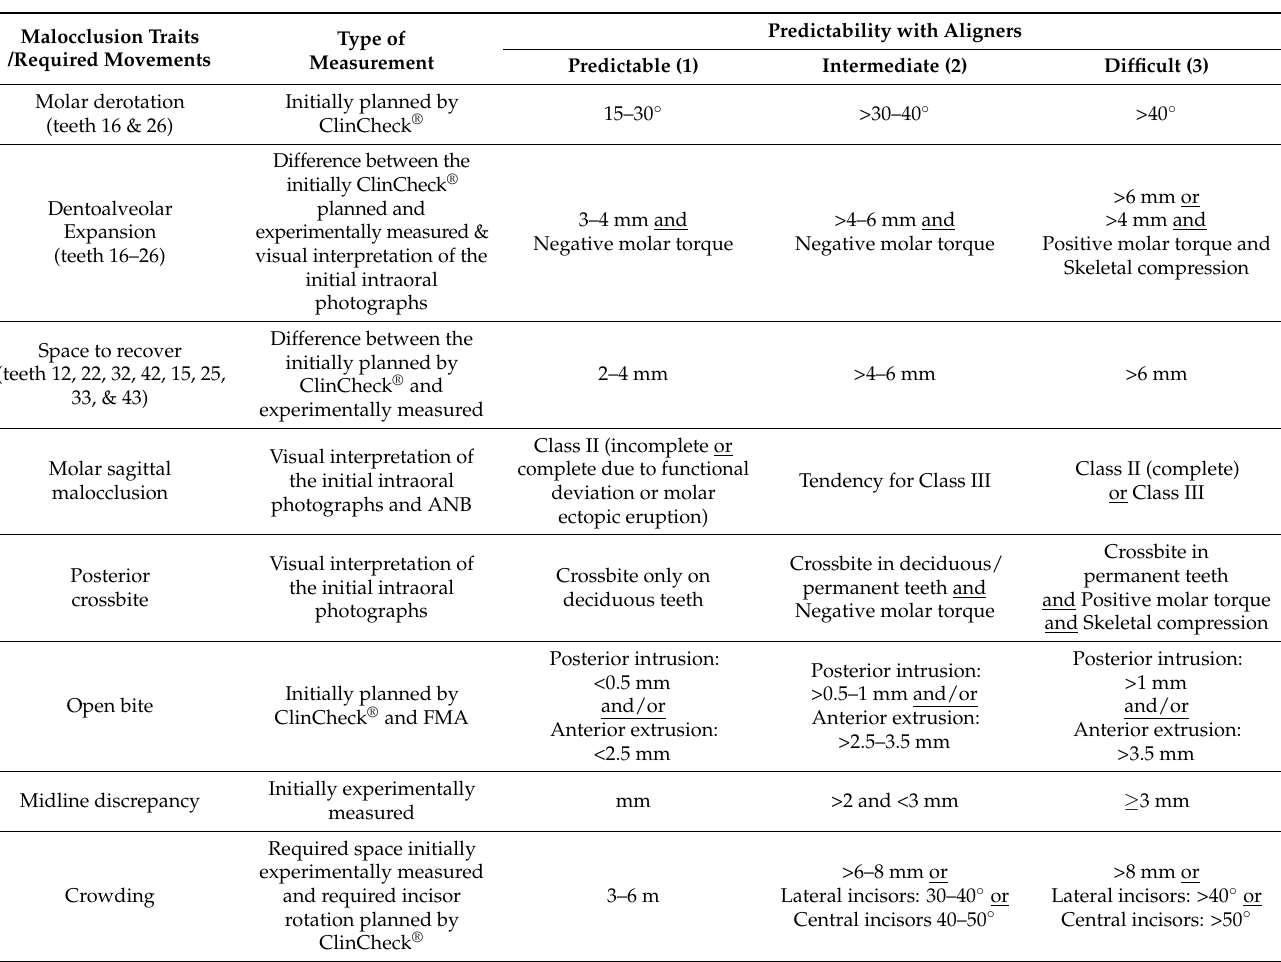
Table 1. Reference values for the classification of the malocclusion traits into predictable, interme- diate, or difficult corrections based on Align ® recommendations, with the respective alterations described